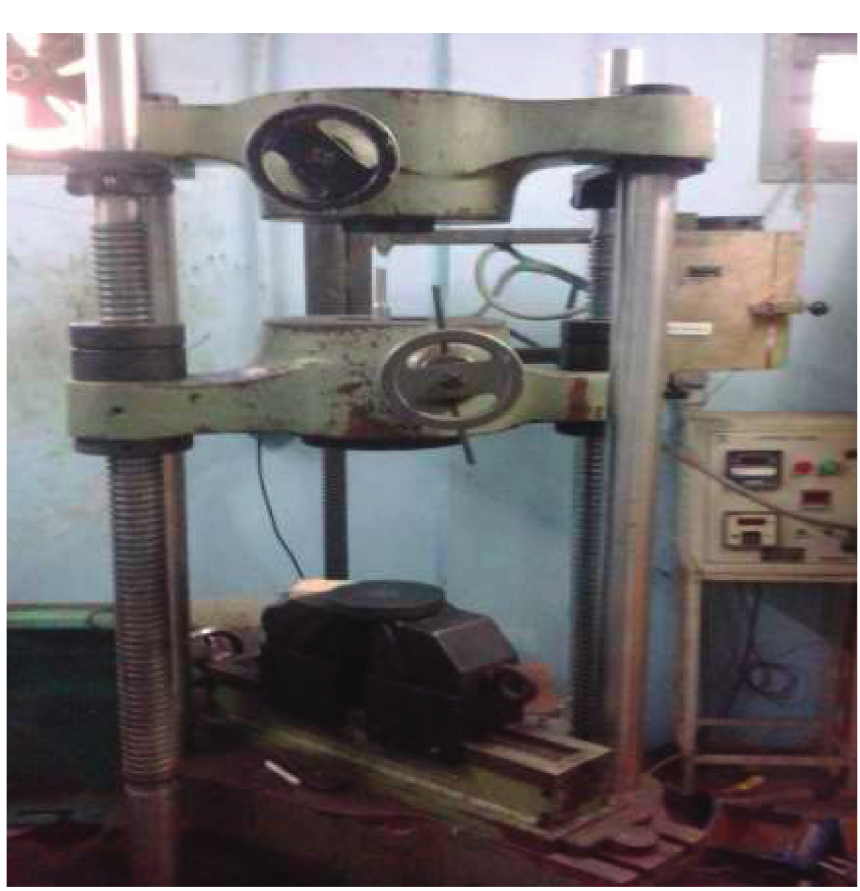
Figure 7: universal testing machine.